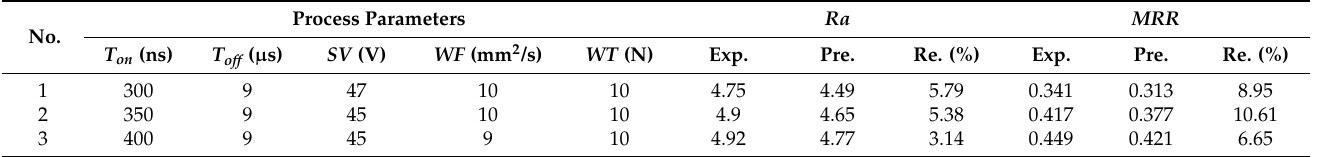
Table 9. The comparison of verified experimental data and predicted